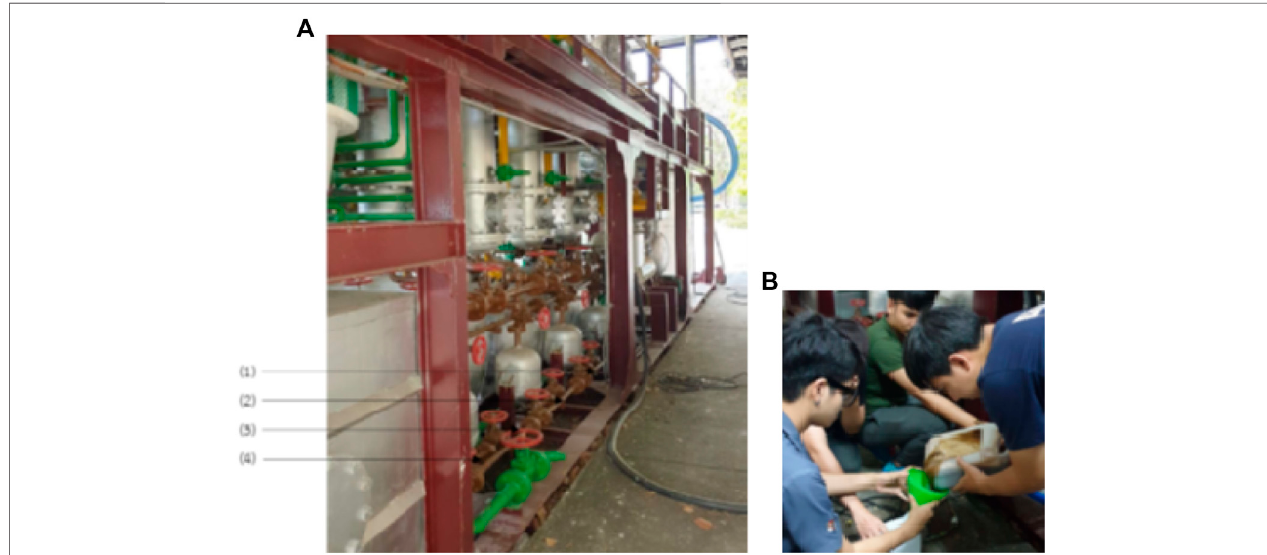
FIGURE 4 | Collecting pyrolysis oil samples (A) four collecting areas and (B) Collecting the condensed pyrolysis oil.